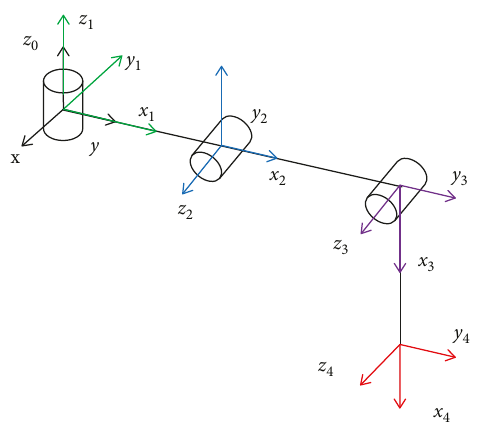
Figure 2: The D-H coordinate system of one leg. Table 1: The D-H parameters of one